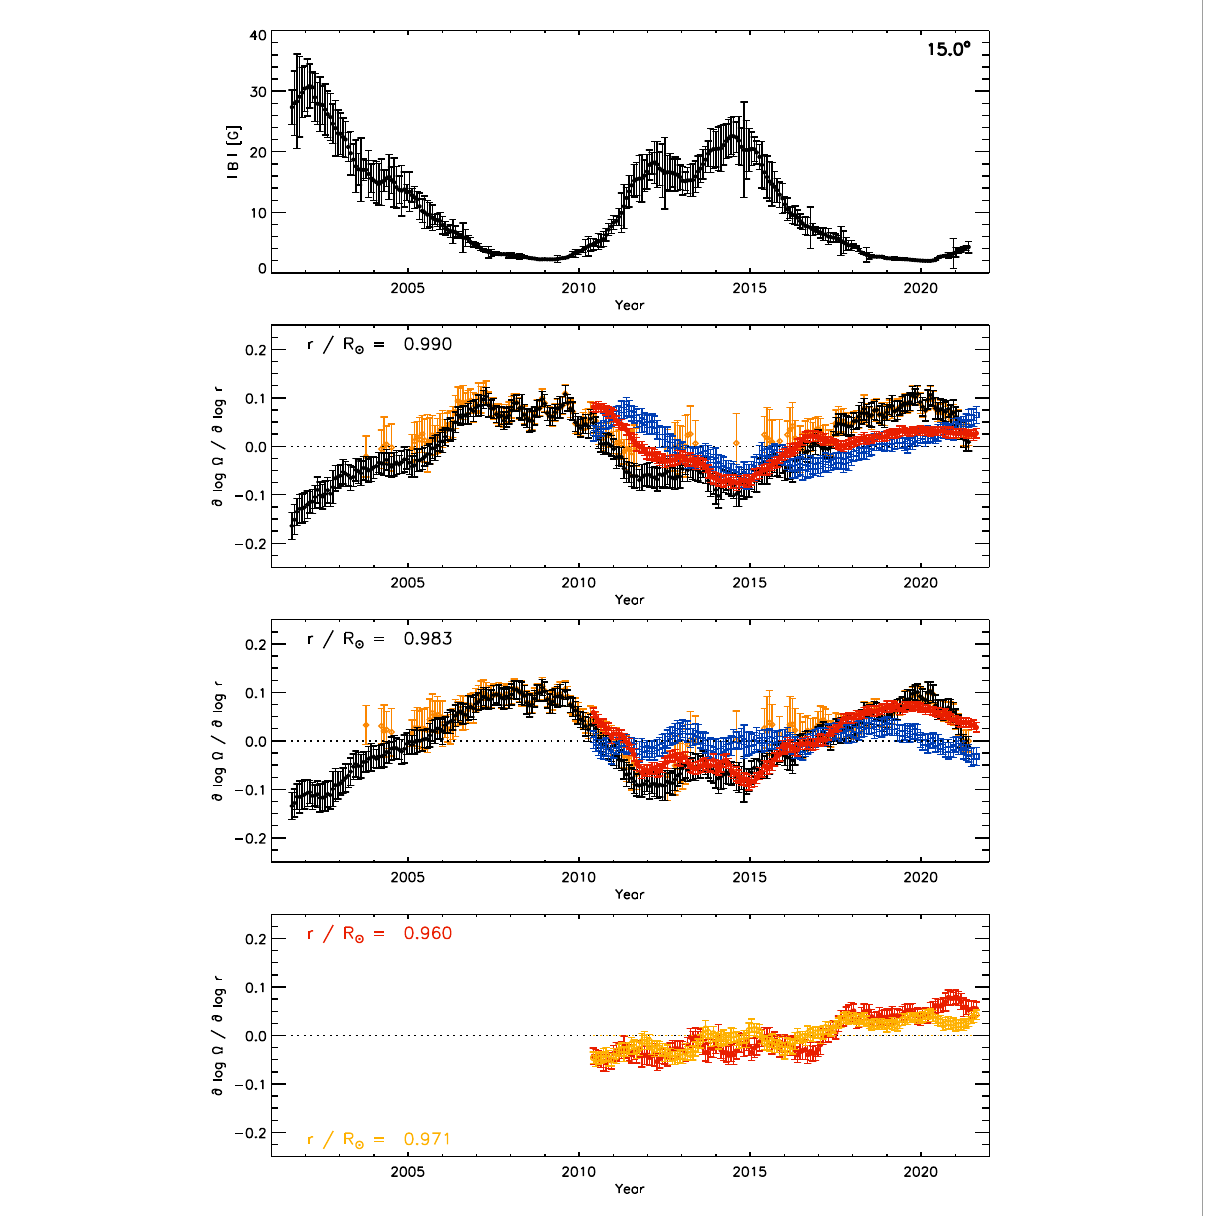
FIGURE 11 The temporal variation of MAI (top) and that of the residual radial gradient of the solar rotation rate after subtracting the temporal mean at every latitude at three depths (2nd: .990 R ⊙ , 3rd: .983 R ⊙ , bottom: .960 R ⊙ ) at 15° latitude averaged over both hemispheres derived from 15°-tile RDA (black diamonds: GONG, blue squares: HMI) and 30°-tile RDA (red circles: HMI) smoothed with a rectangular boxcar over 13 CRs. For the GONG quiet-region subset (orange open diamonds), the mean of the complete data set was subtracted. The bottom panel includes the variation at .971 R ⊙ (orange open circles). Compare with Figures 9 , 10